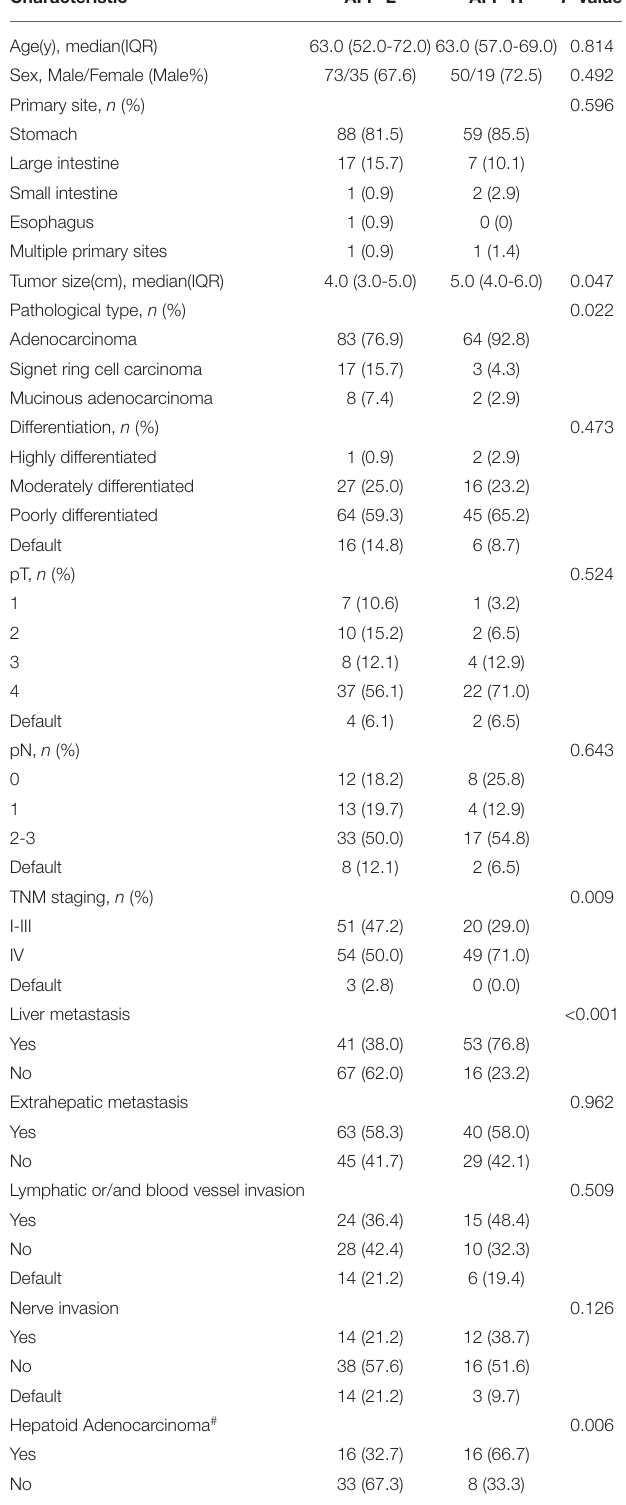
TABLE 2 | Comparison of clinical baseline characteristics of APA-GI patients with different serum AFP levels.